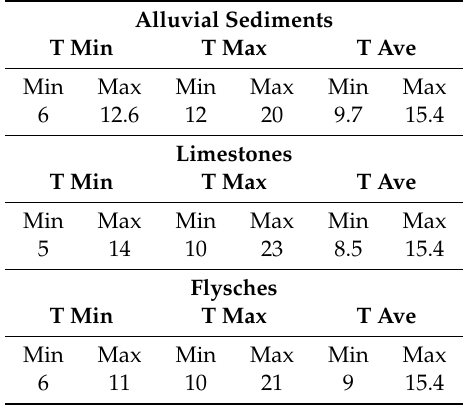
Table 3. Spring temperature variations for the three main hydrogeological systems: limestones, flysches and alluvial